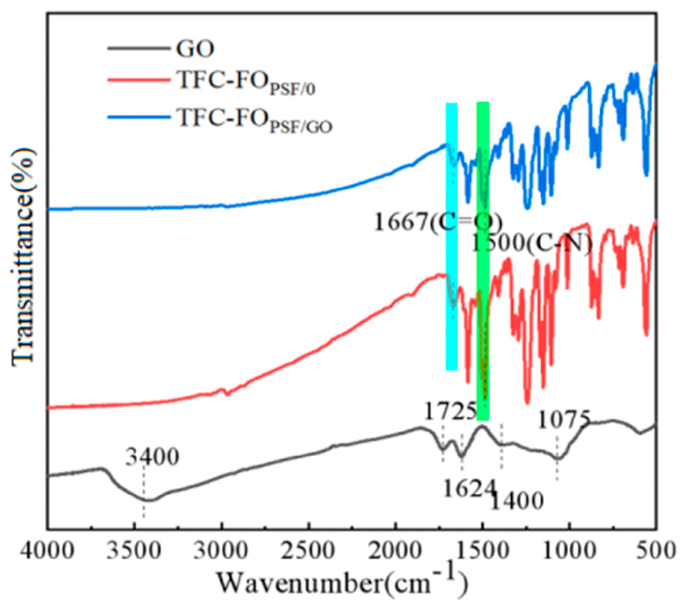
Figure 3. FTIR spectra of GO nanoparticles, undoped, and 0.15 wt% GO-doped TFC membranes.